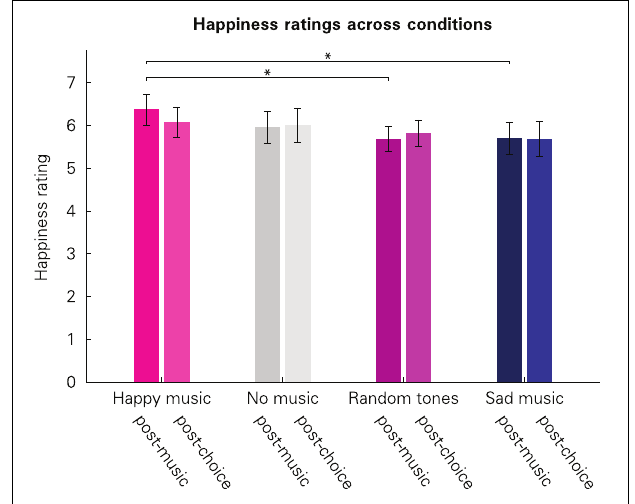
FIGURE 2 | Subjective happiness ratings across the four conditions. Darker bars illustrate the values immediately after musical stimulation (“post-music”); brighter bars illustrate the values after the lottery choice blocks (“post-choice”). Error bars represent 95% confidence intervals. The scale ranged from 1 (not happy at all) to 9 (very happy). An asterisk indicates significant difference at the 5%